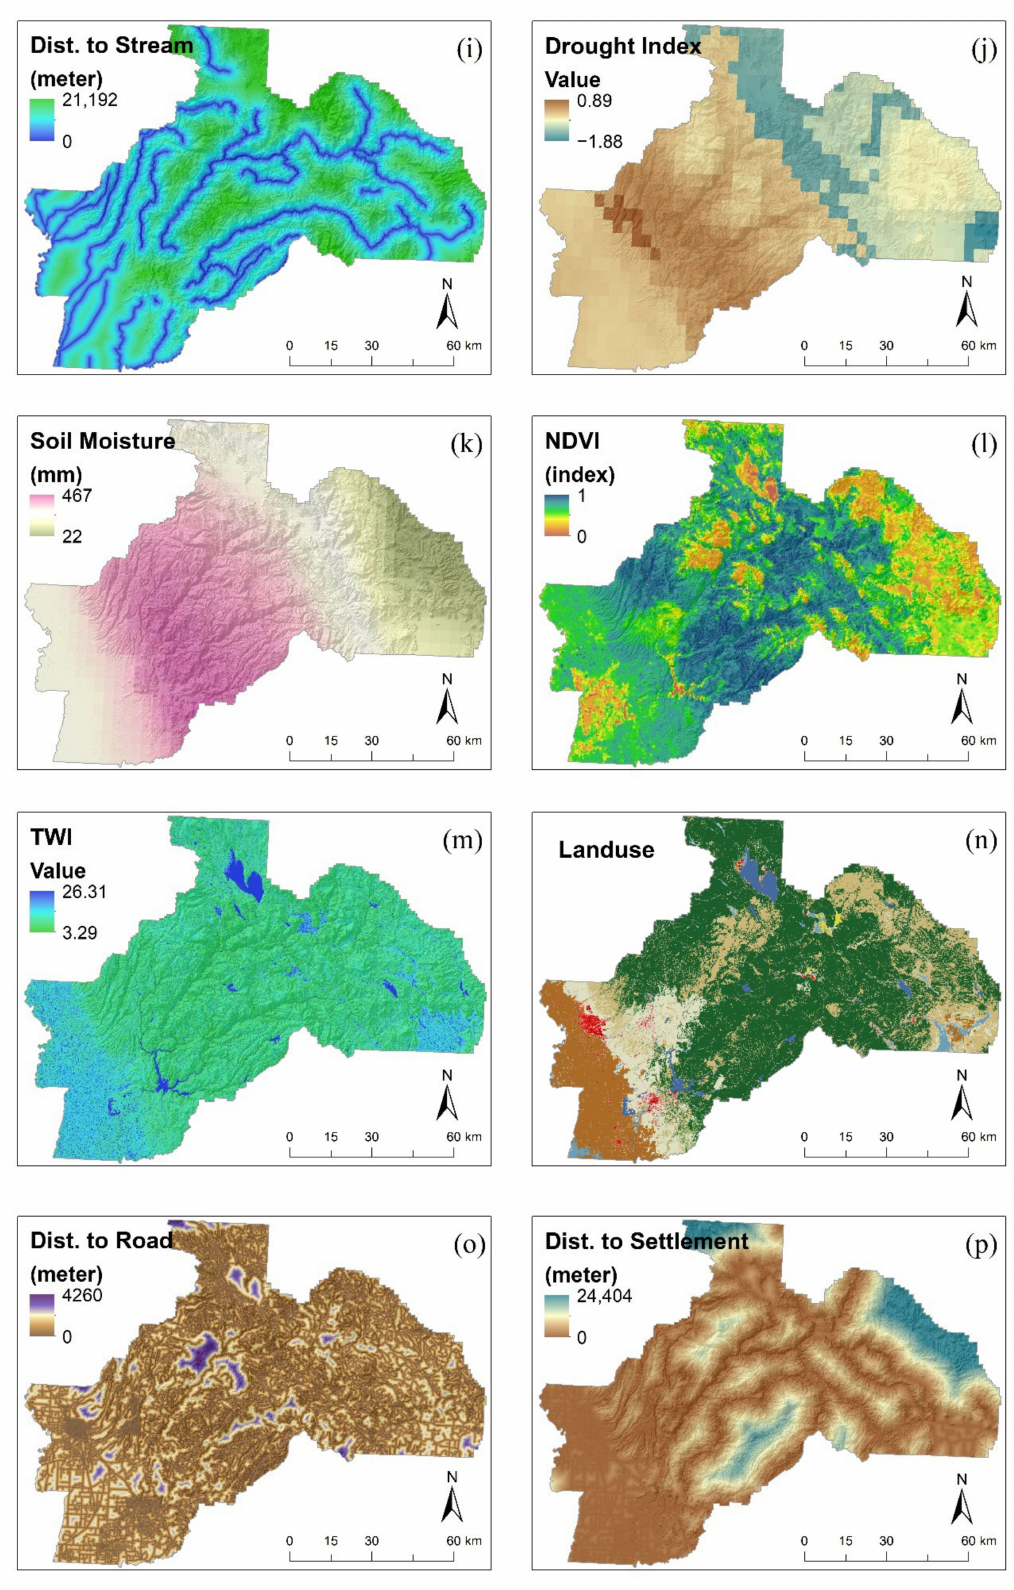
Figure 4. Wildfire conditioning factors used in this study categorized as ( a – d ) topographical, ( e – h ) meteorological, ( i – m ) environmental, and ( n – p ) anthropological